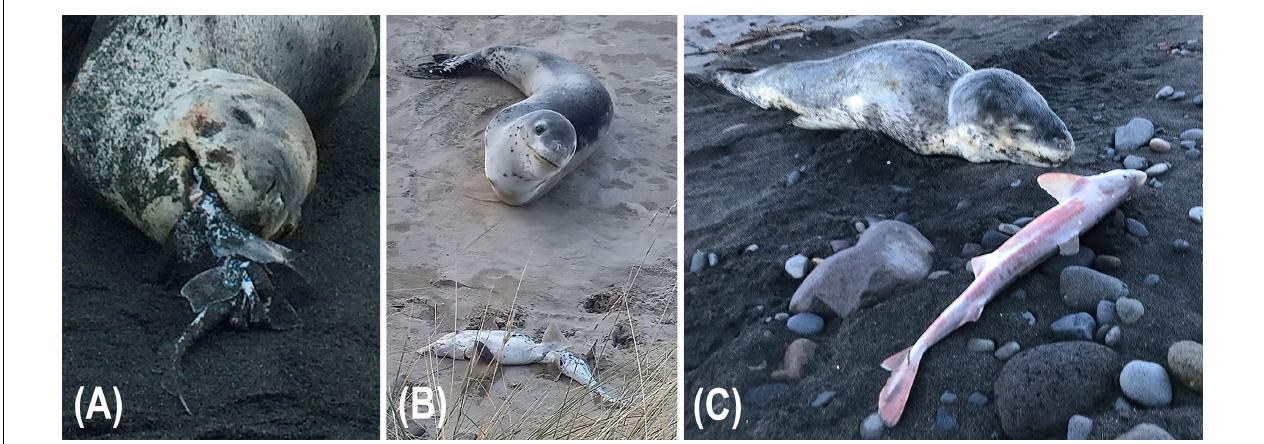
FIGURE 2 | Leopard seal ( Hydrurga leptonyx ) observations of predation in New Zealand, involving intact prey items: (A) unidentified adult of unknown sex, sighted 3 September 2015, at Mangamaunu Beach, Hapuku, Canterbury, with a partially ingested ghost shark, photograph Sue Parsons; (B) adult female HLNZ-P057, sighted 9 August 2017, at Riverton Beach, Riverton, Southland, with an elephantfish ( Callorhinchus milii ) laying adjacent, photograph Anita Spencer; (C) juvenile female HLNZ-P111, sighted 21 August 2018, at Ohawe Beach, Whanganui, with spiny dogfish ( Squalus acanthias ) laying adjacent, photograph Karen Pratt.